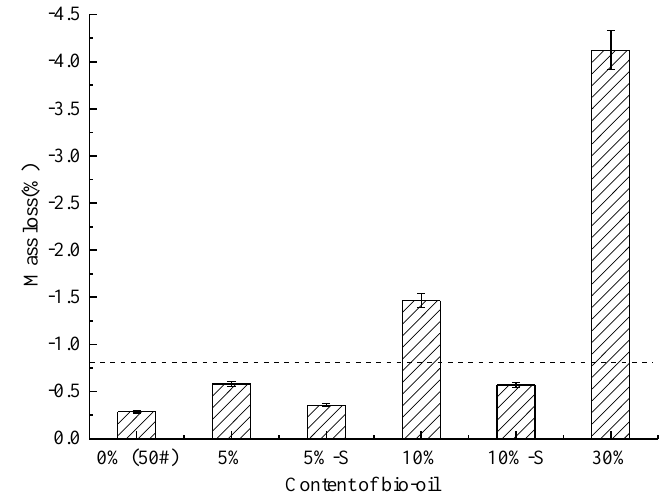
Figure 6. Mass loss between unaged and RTFO aged bio-asphalt.